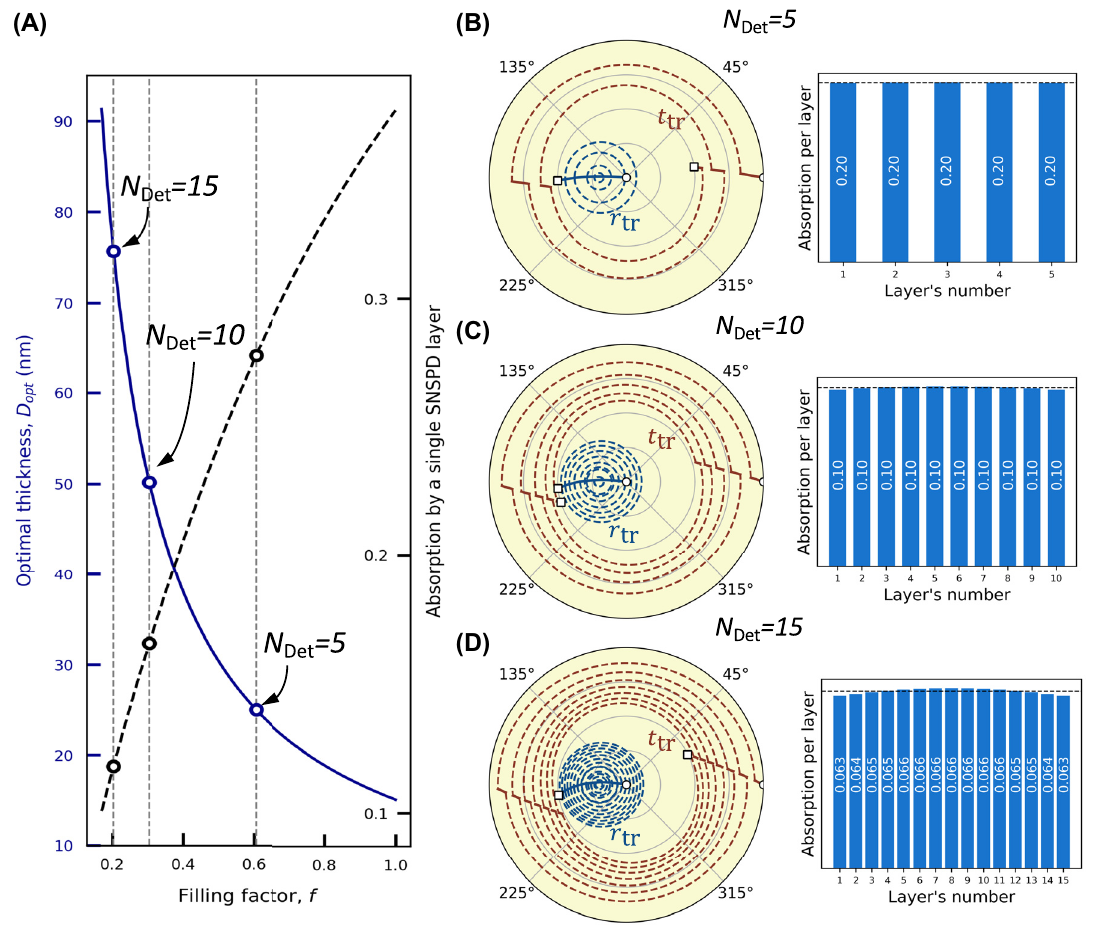
Figure 5: Performance of a multilayer distributed detector. (A, left vertical axis): Optimal thickness (solid purple line) of a single-layer SNSPD as a function of the filling factor. (A, right vertical axis): absorption (traveling wave) of a 5 nm thick nanowire as a function of the filling factor (dashed black line). Empty circles mark parameters for fabricating five-, ten-, and fifteen-layer distributed detectors. (B)–(D) For these three cases, circular diagrams and absorption per layer (under a standing wave illumination) are